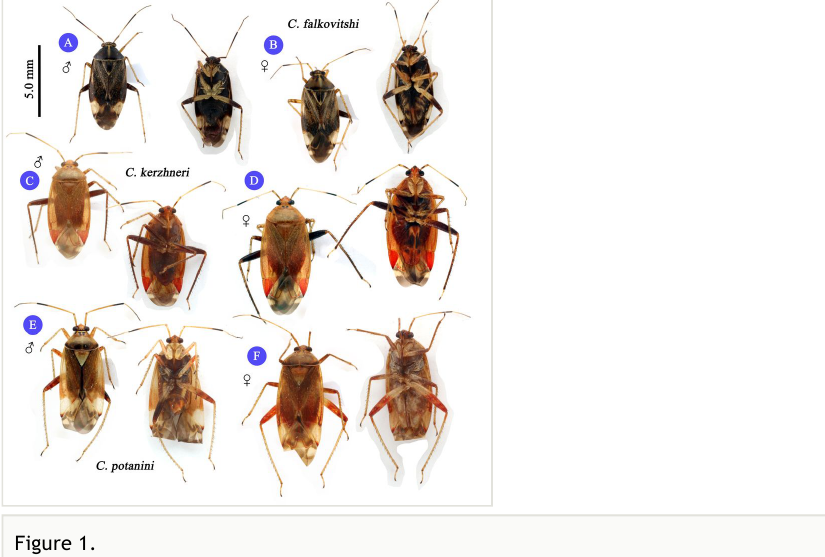
Figure 1. Dorsal and ventral habitus of Korean Castanopsides species (A–B: C. falkovitshi ; C–D: C. kerzhneri ; E–F: C. potanini